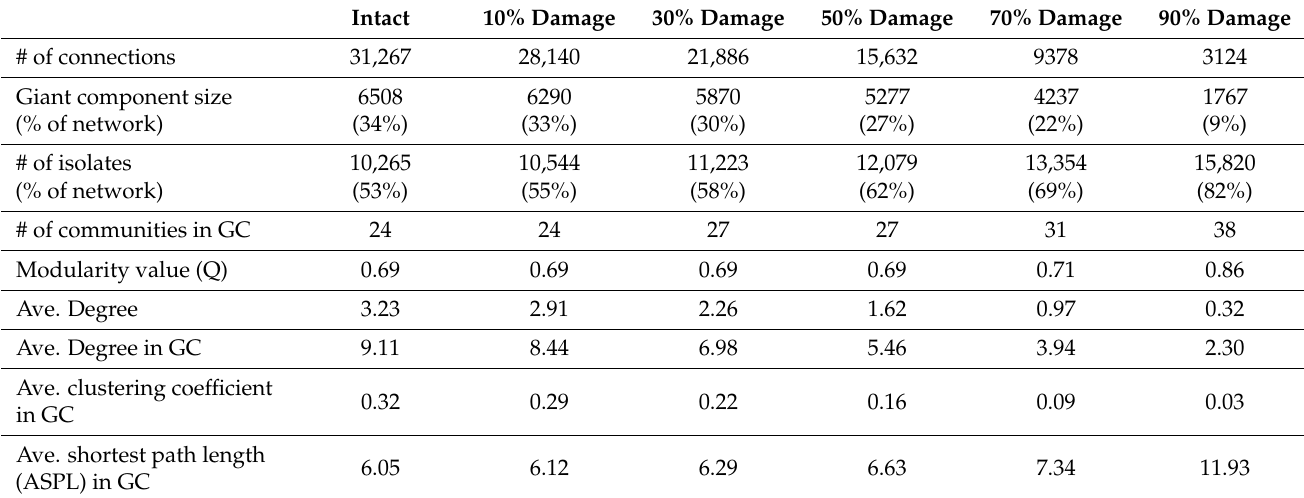
Table 1. Network measures of the intact and damaged networks.